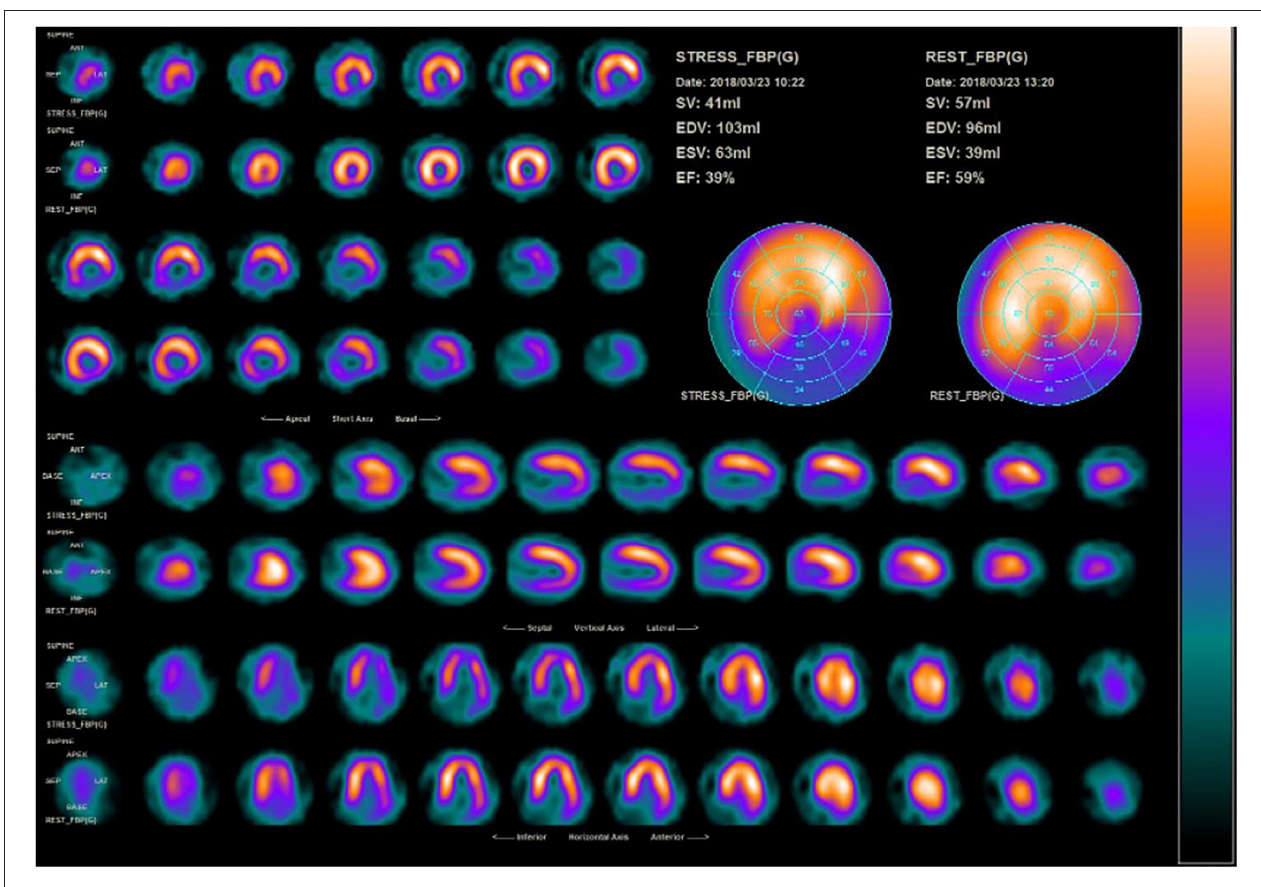
FIGURE 1 | SPECT examination of patient 1 before ESMR therapy.